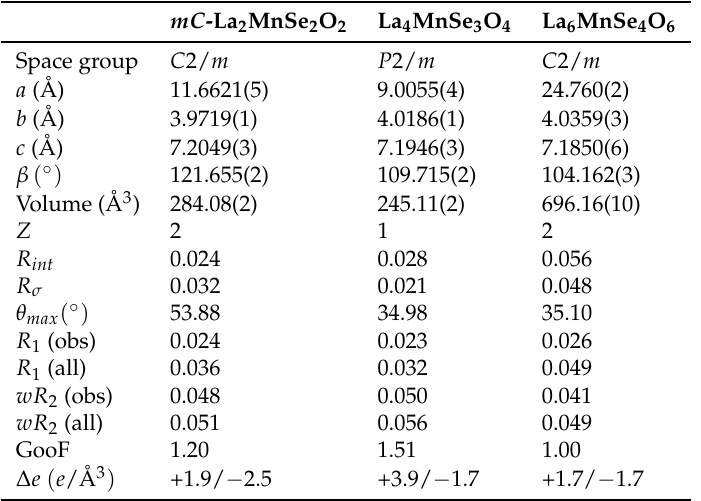
Table 1. Crystal data and structure refinement of La 2 n +2 MnSe n +2 O 2 n +2 ( n = 0, 1,